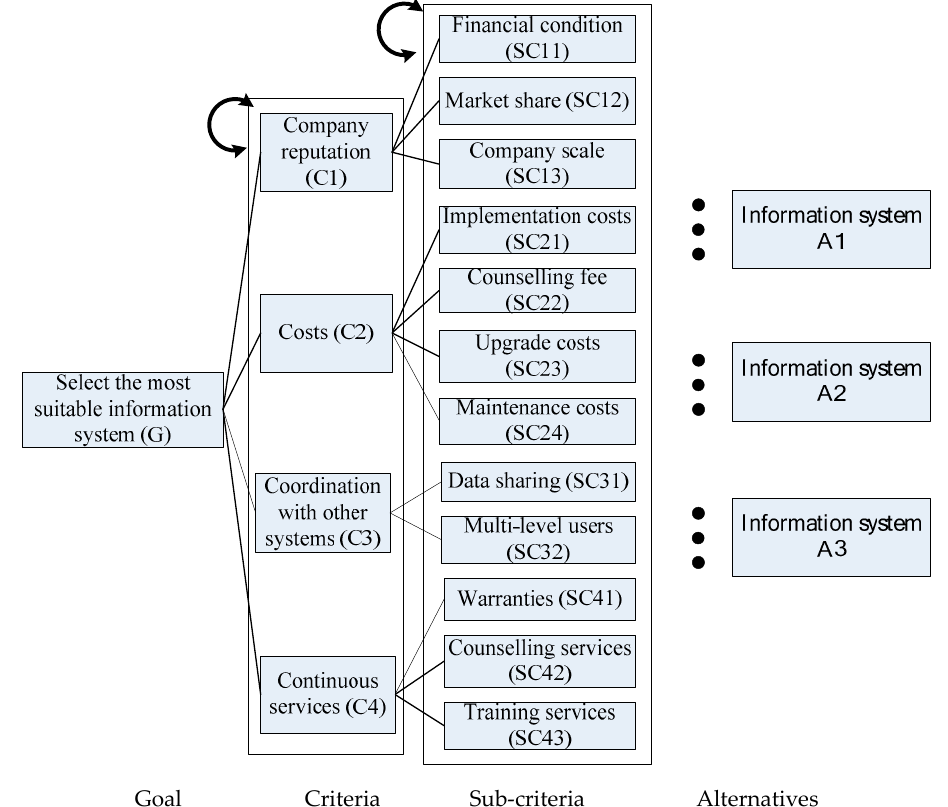
Figure 2. Initial information system evaluation network.